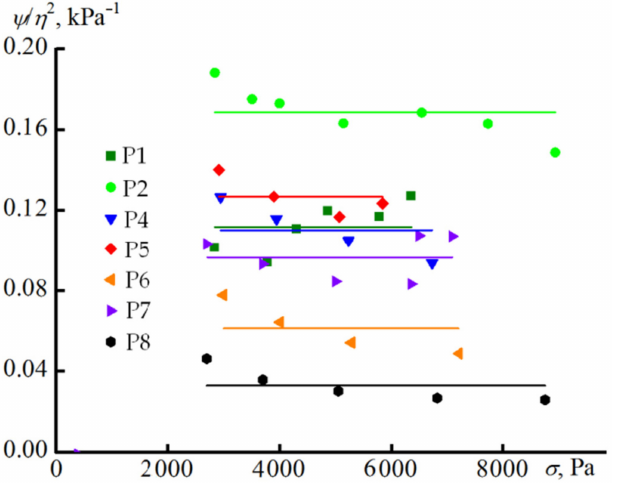
Figure 7. Shear stress dependence of the ratio between the coefficient of the first normal stress differ- ence and the square of the viscosity at 190 ◦ C. The polymer numbers are presented in the